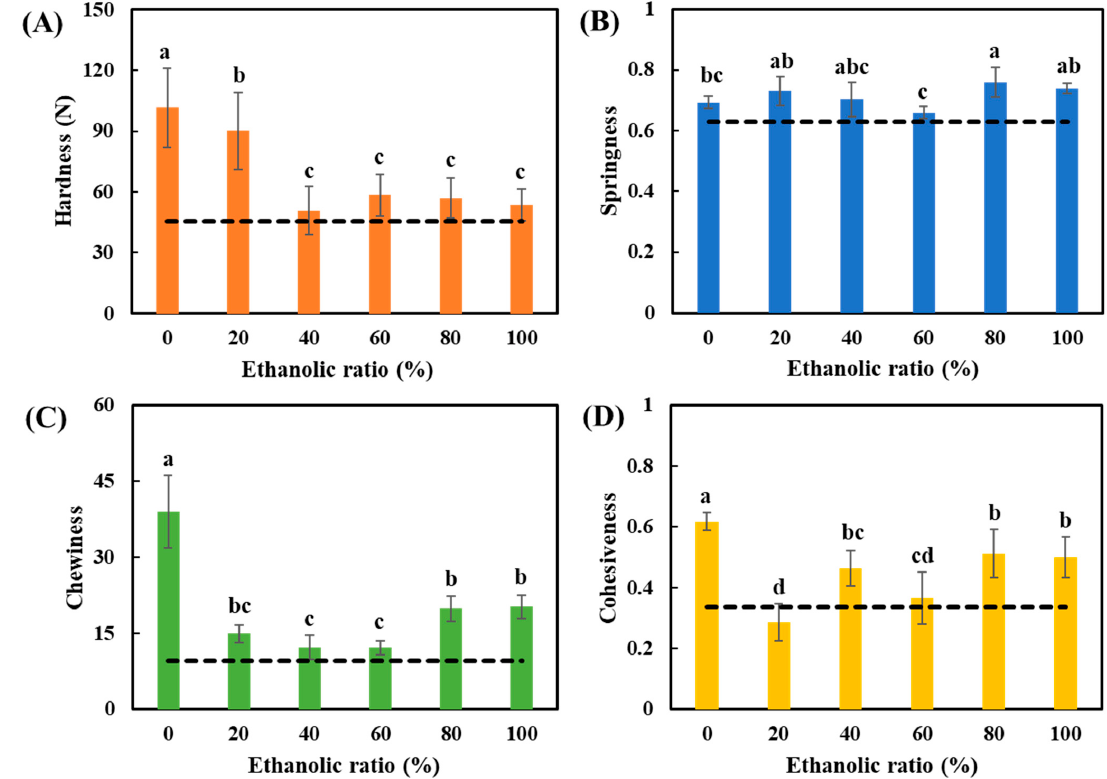
Figure 11. Textural analysis on ( A ) Hardness, ( B ) Springiness, ( C ) Chewiness and ( D ) Cohesiveness of all the soy gels (standardized 15 wt% protein content). The black square dotted lines represent the reference value measured from commercial SPC gels. The values in the figure are compared and different top letters (a,b,c,d) indicate a significant difference ( p < 0.05).